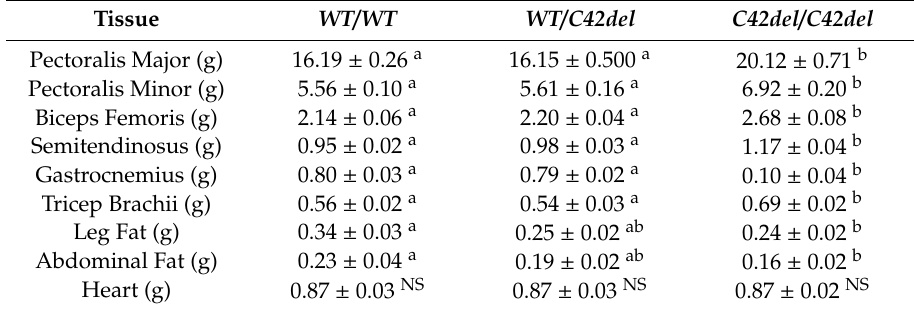
Table 1. Comparison of muscle, adipose tissue, and heart weights in 6-week old female quail.